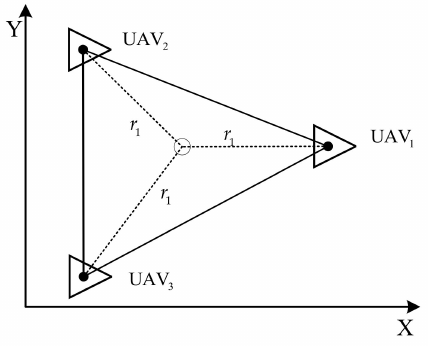
Figure 4. Geometry of the formation.